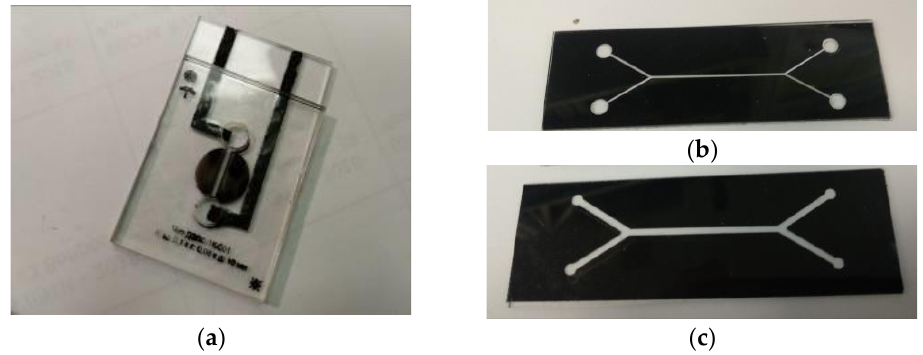
Figure 4. Sample capillary chips for LLS measurements: capillary (H × W × L) 0.1 mm × 1 mm × 10 mm ( a ); 0.08 mm × 0.7 mm × 30 mm ( b ); and 0.08 mm × 1.5 mm × 30 mm ( c ).